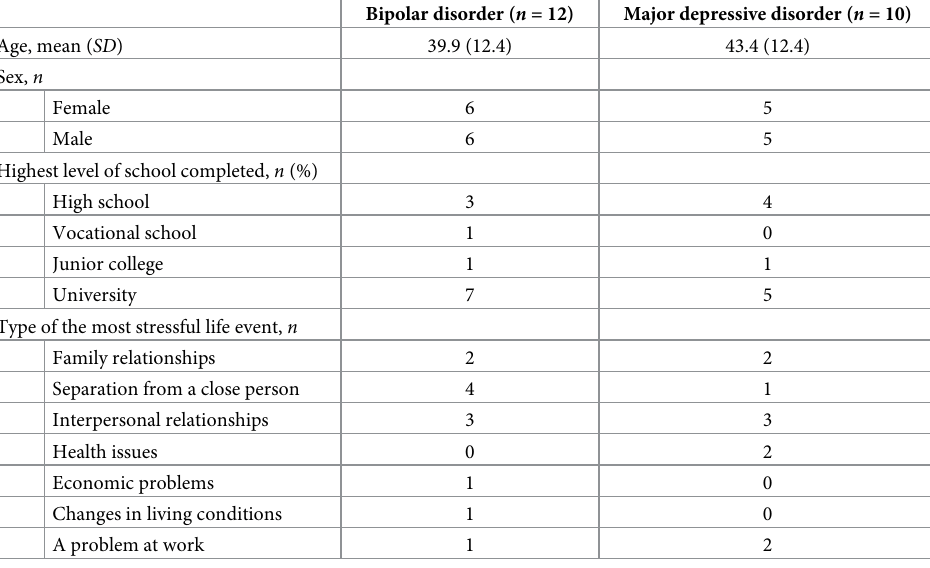
Table 1. Participants’ characteristics in Step